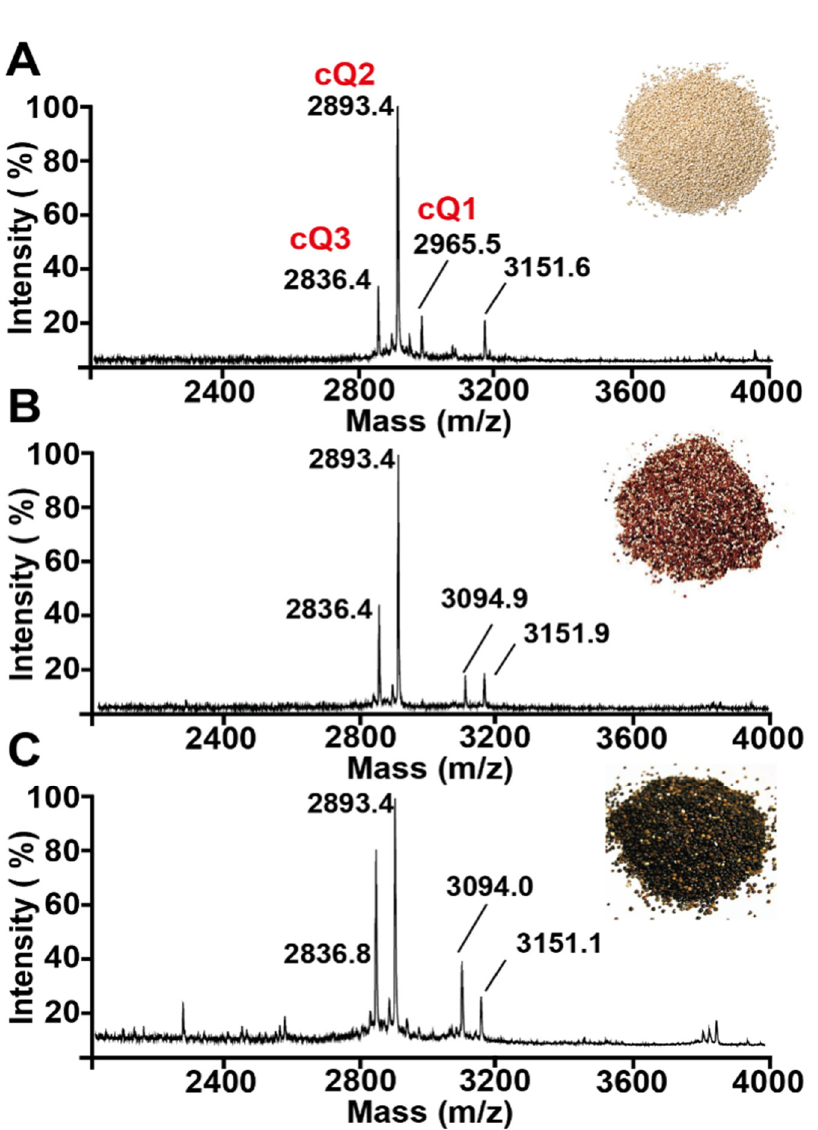
Figure 1. MALDI-TOF MS profile of aqueous quinoa extracts. ( A ) C. quinoa var. Willd, ( B ) C. quinoa var. red, ( C ) C. quinoa var. black. Clusters of peaks in the range of 2–4 kDa indicate the presence of putative cysteine-rich peptides. Chenotides cQ1, cQ2, and cQ3 are labeled with their corresponding peaks.